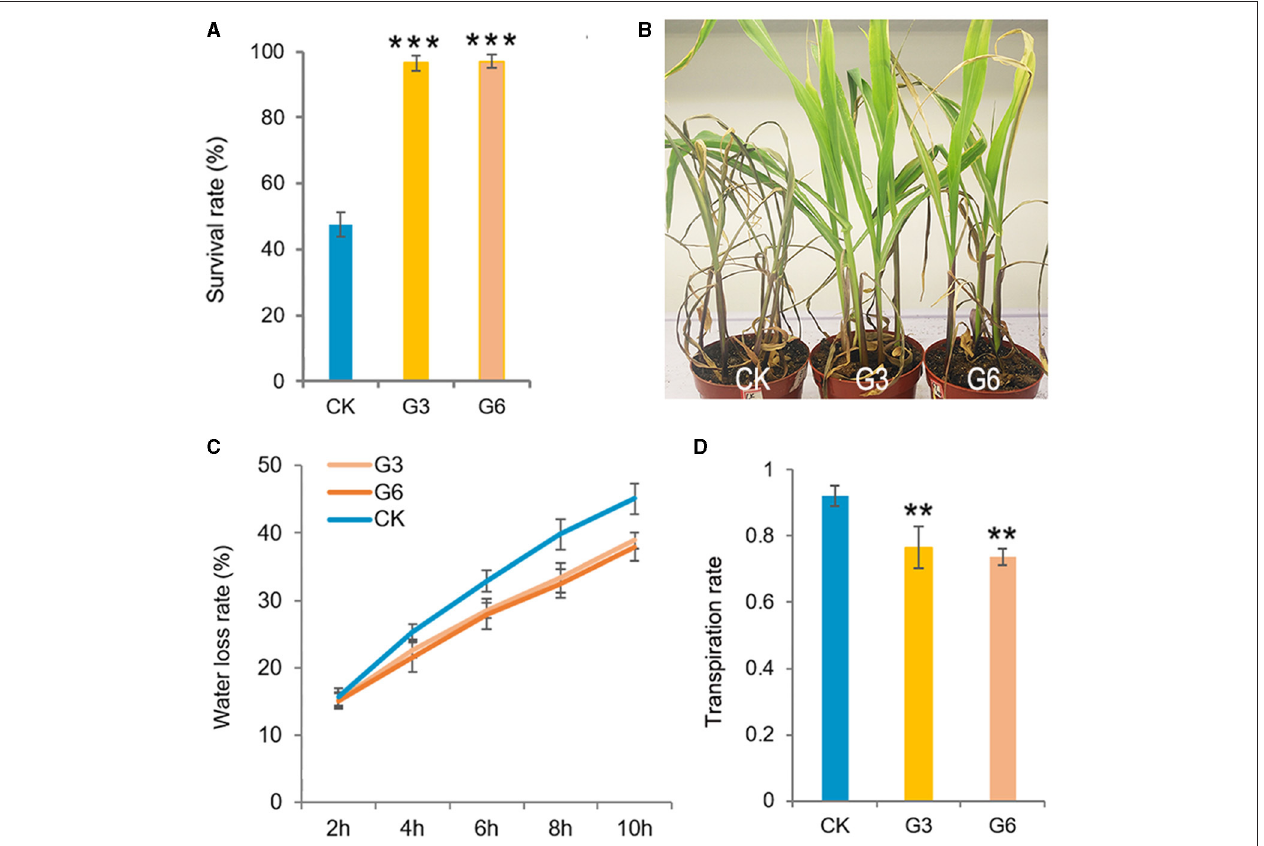
FIGURE 4 | ZmGT-3b knockdown increases drought tolerance in GT-KD seedlings. The survival rate (SR) (A) and the phenotypes of the wilted or survived maize seedlings rewatered after serious drought treatment (B) . CK (maize inbred line LH244, wild type), G3 and G6 seedlings were shown at 6 days after rewatering. Water was withheld from growing seedlings at the two-leaf stage, and the plants were rewatered when all CK seedlings were severely wilted (at ∼ 25 DAG). Values are the mean ± SD ( n > 25) (C) Leaf water loss rates (WLRs) of young maize ( Z. mays ) seedlings. The leaf WLRs are shown as the means of the percentage of leaf water loss ± SD ( n = 6). Three independent experiments were performed with the third leaf of each seedling. (D) The transpiration rate (TR) of the maize seedling leaves. The estimated TR was obtained from the central widest part of the third leaf, which is the newest expanded leaf of 15 DAG CK or GT-KD seedlings (with three leaves and a heartleaf). The TR value was measured simultaneously with the Pn from 09:00 to 12:00 under natural light in a greenhouse, TR values are the mean ± SD ( n = 5). The asterisks indicate a statistically significant difference between CK and the GT-KD lines, as calculated by a paired Student’s t -test (** p < 0.01, *** p <